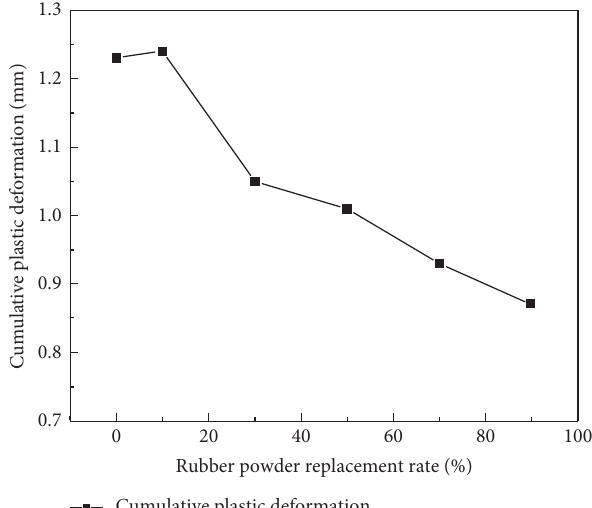
Figure 4: Relationship between rubber powder replacement rate and cumulative plastic deformation of